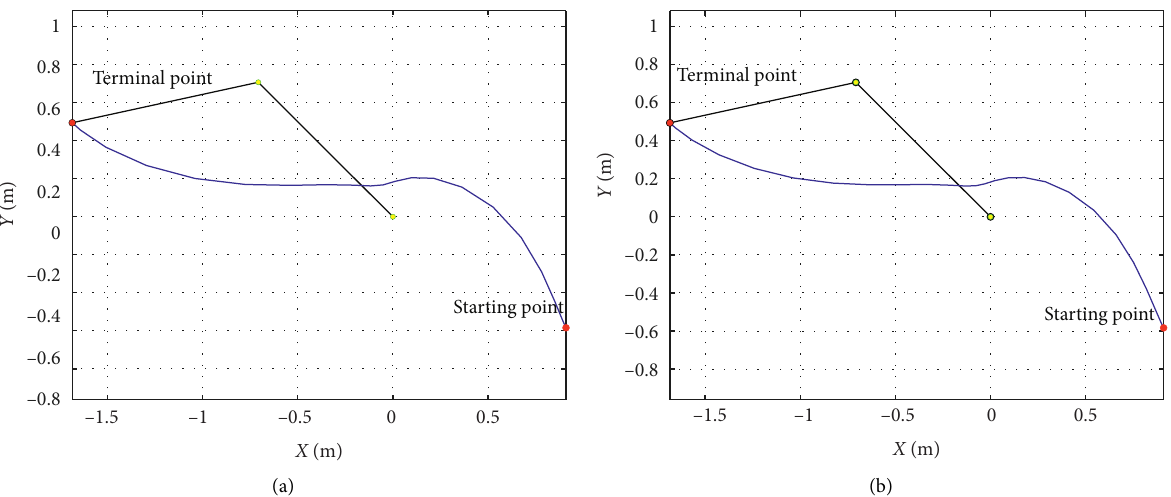
Figure 9: The trajectory of 2-DOF robotic manipulator in case 3. (a) Conventional B-spline optimization. (b) Improved B-spline